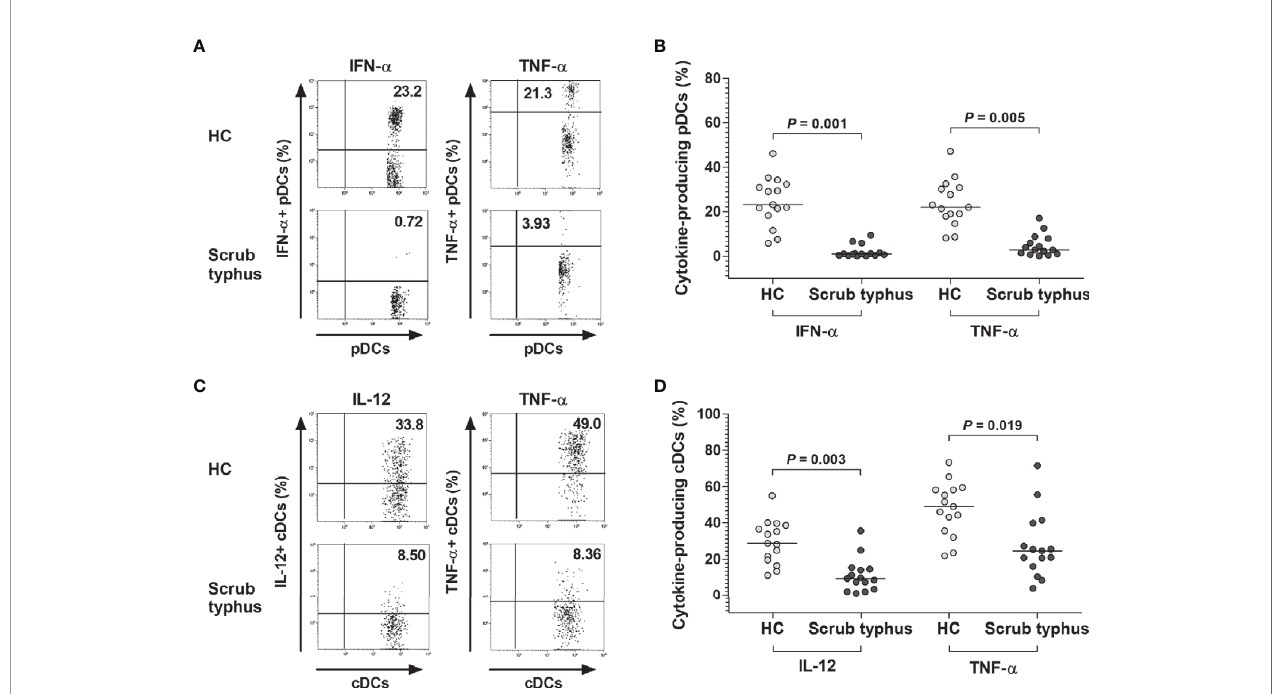
FIGURE 3 | Decreased expression of IFN- a , IL-12, and TNF- a in pDCs and cDCs of scrub typhus patients. Freshly isolated PBMCs (1 × 10 6 /well) were incubated for 2 hours in the presence of CpG or the non-CpG ODN control for pDC stimulation, and in the presence of IFN- g and LPS for cDC stimulation. (A, C) Representative IFN- a -, IL-12-, and TNF- a -expressing pDCs or cDCs as determined by fl ow cytometry. The data in (B, D) were obtained from 15 HCs and 15 patients with scrub typhus. The symbols represent individual subjects and the horizontal lines are median values. P values were calculated by ANCOVA test.